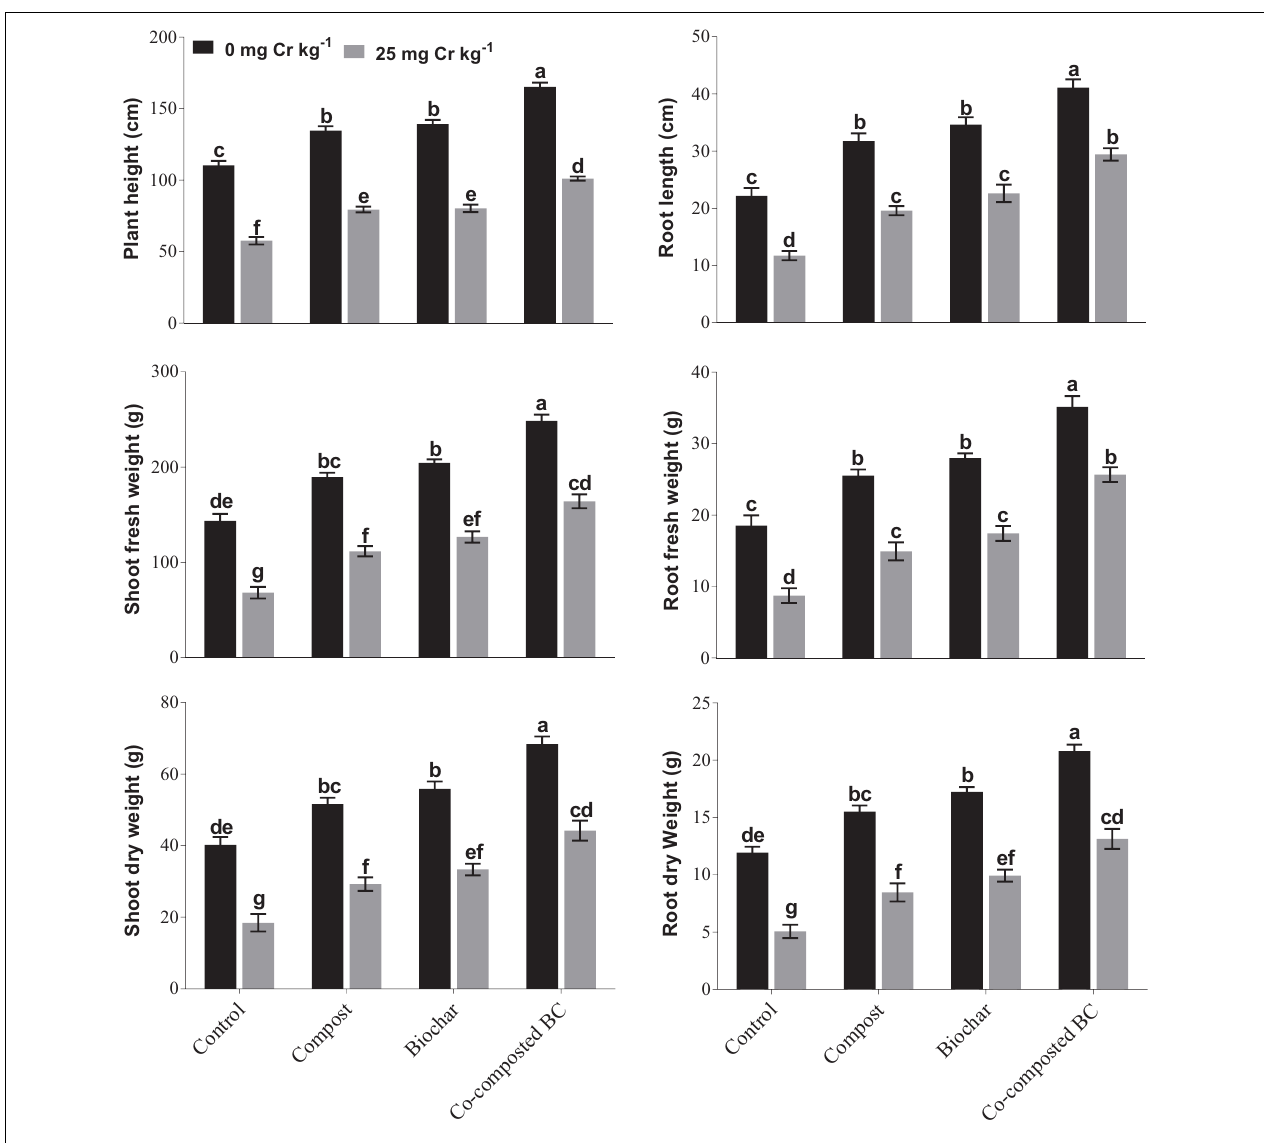
FIGURE 1 | Impact of compost, biochar, and co-composted biochar on growth and yield parameters of Brassica . The values are presented as mean ± standard error ( n = 3). The values sharing the same letter(s) in bars are statistically non-significant with each other at p < 0.05.